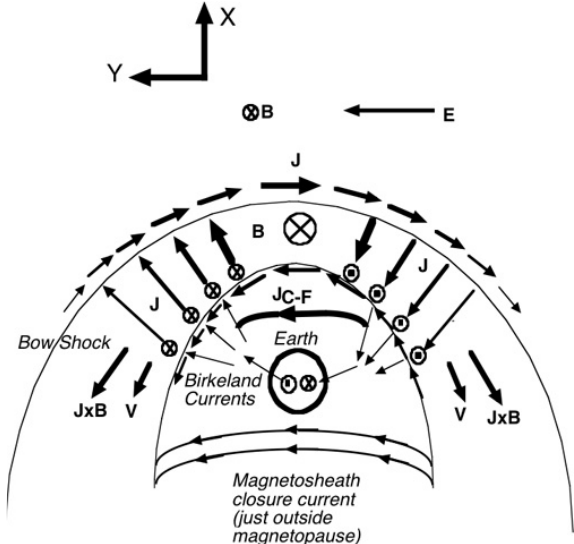
Fig. 5. A schematic for current closure through the geospace system for conditions of large purely southward IMF as viewed from above the north